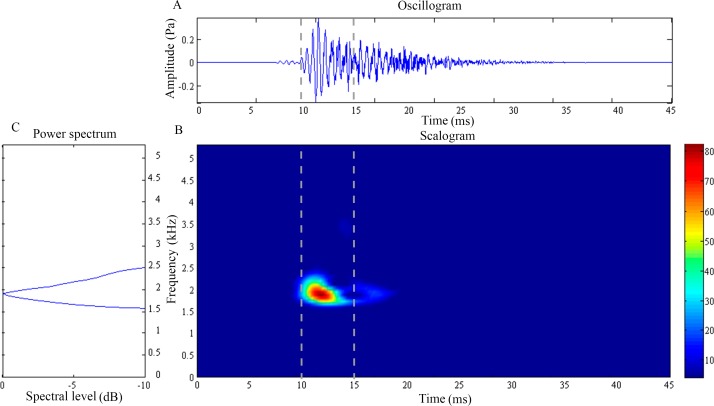
Wavelet analysis results of the feeding click produced by Syngnathoides biaculeatus.(A) Oscillogram, (B) scalogram and (C) energy spectral density of the feeding clicks produced by Syngnathoides biaculeatus. Vertical lines in (A) and (B) indicate the measured signal duration.